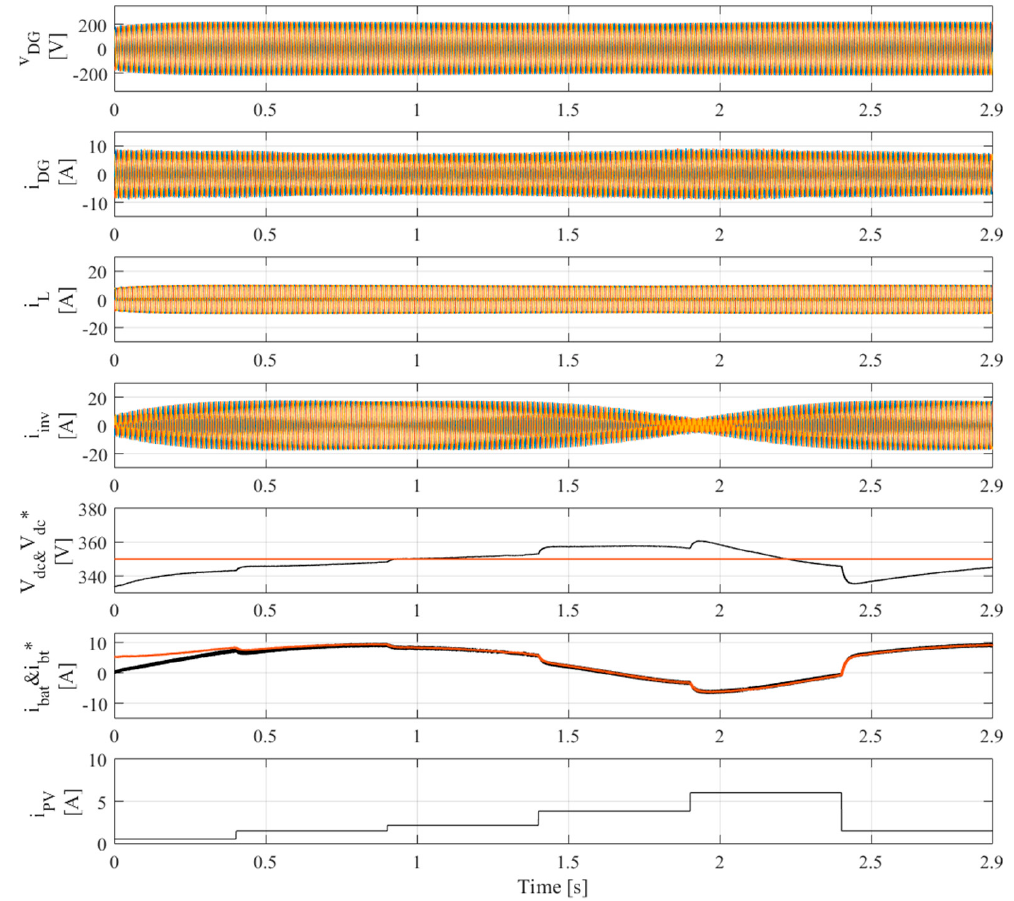
Figure 7. Dynamic performance under presence of balanced RL nonlinear load and solar irradiation change.